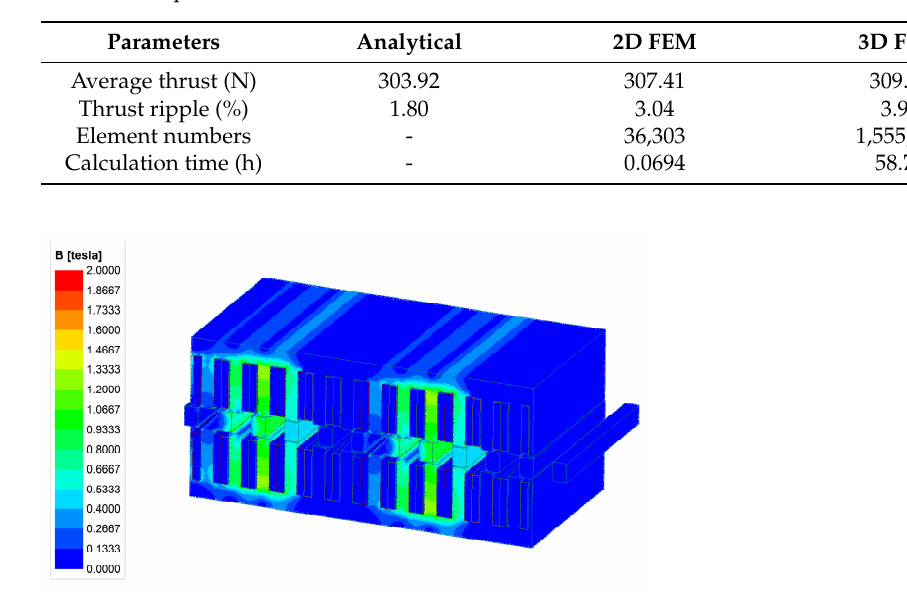
Figure 18. 3D magnetic flux density distribution map of DCB-VRLM with non-uniform air gap.